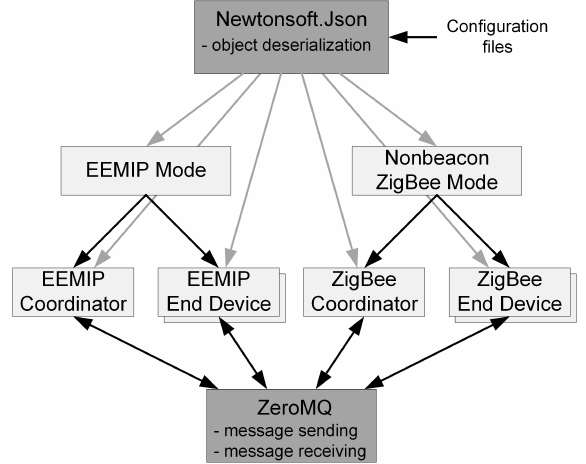
Figure 5. Simulator architecture